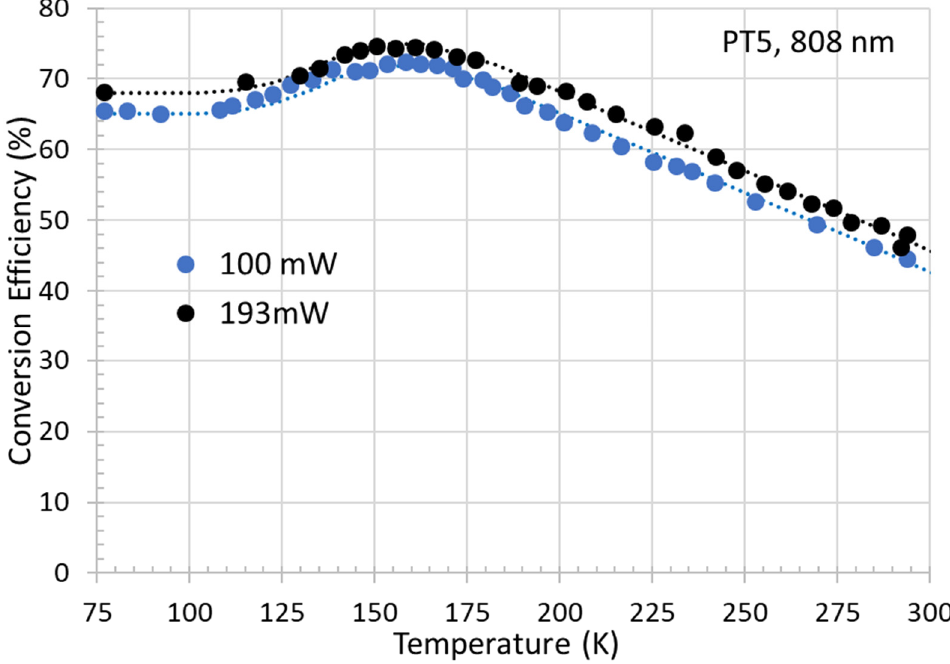
Figure 4. Conversion efficiency as a function of the temperature for the PT5 device with an optical input at 808 nm at 100 mW and 193 mW of input power.